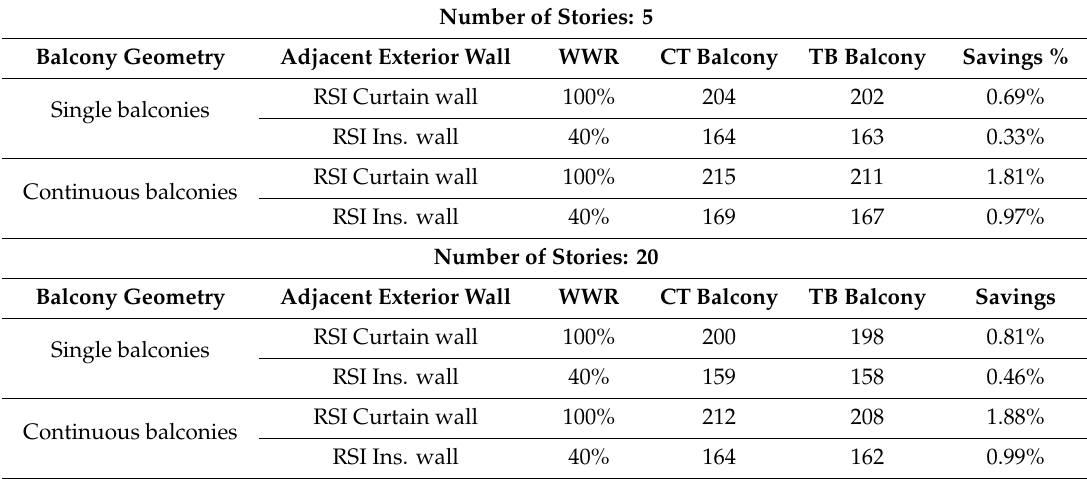
Table 7. The annual space heating energy use intensity (kWh / m 2 ) and energy use